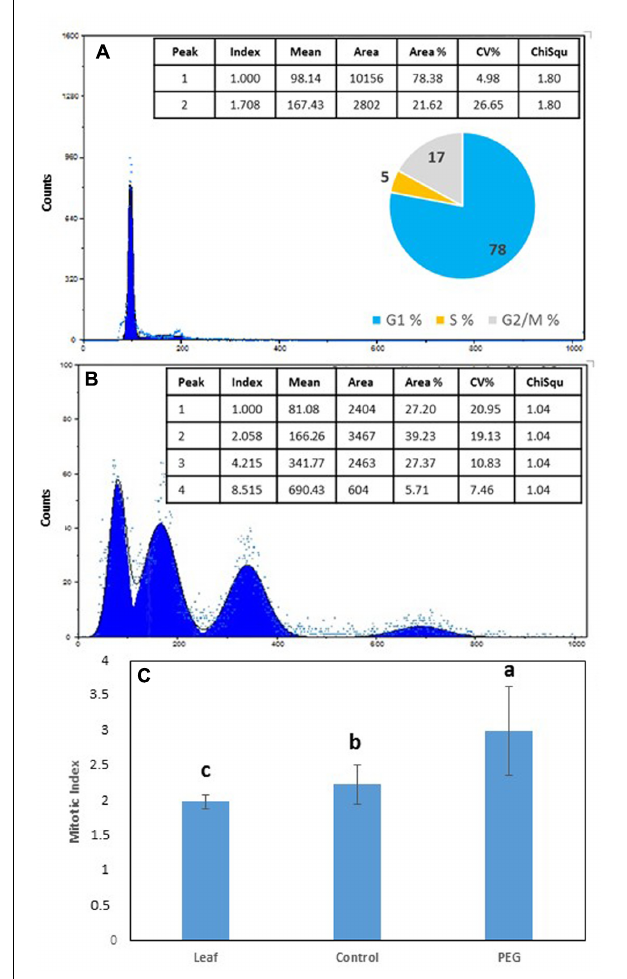
FIGURE 3 | Flow cytometry (FCM) profile and % distribution of nuclei in G1 (1st peak), G2 (2nd peak), S phase (trough between 1st and 2nd peaks) and polyploid nuclei [3rd (8C) and 4th (16C) peaks] from (A) leaves of Medicago truncatula , (B) M. truncatula callus cultured on 10% w/v PEG6000 for 6 months; (C) Mean ( ± SD) mitotic index in leaves compared to callus tissues after 9 continuous months growth on 10% w/v PEG. Different letters indicate significant differences ( P ≤ 0.05); n = 10. See Supplementary File S2 for data and statistical